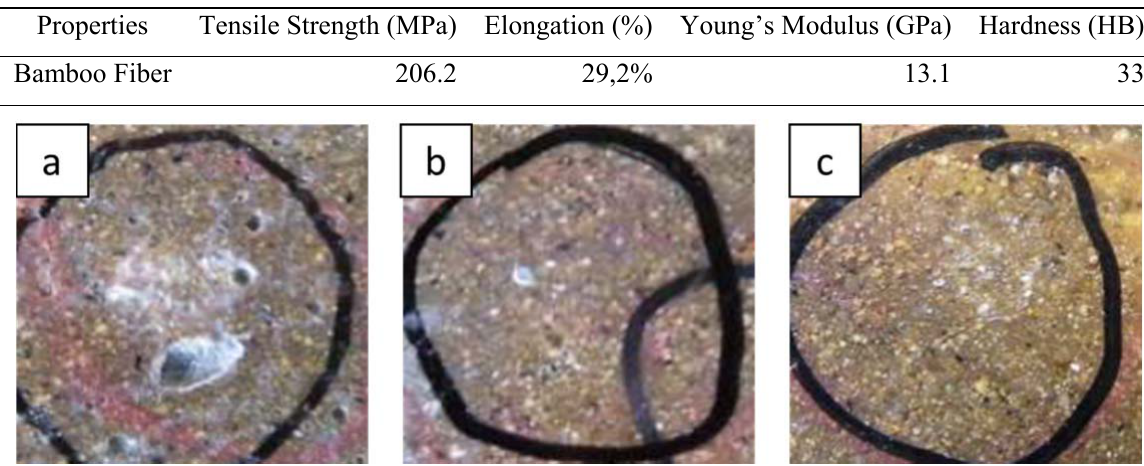
Figure 5. Bamboo Fiber Specimen After Ballistic Testing (a) 2 m (b) 2,5 m (c) 3 m